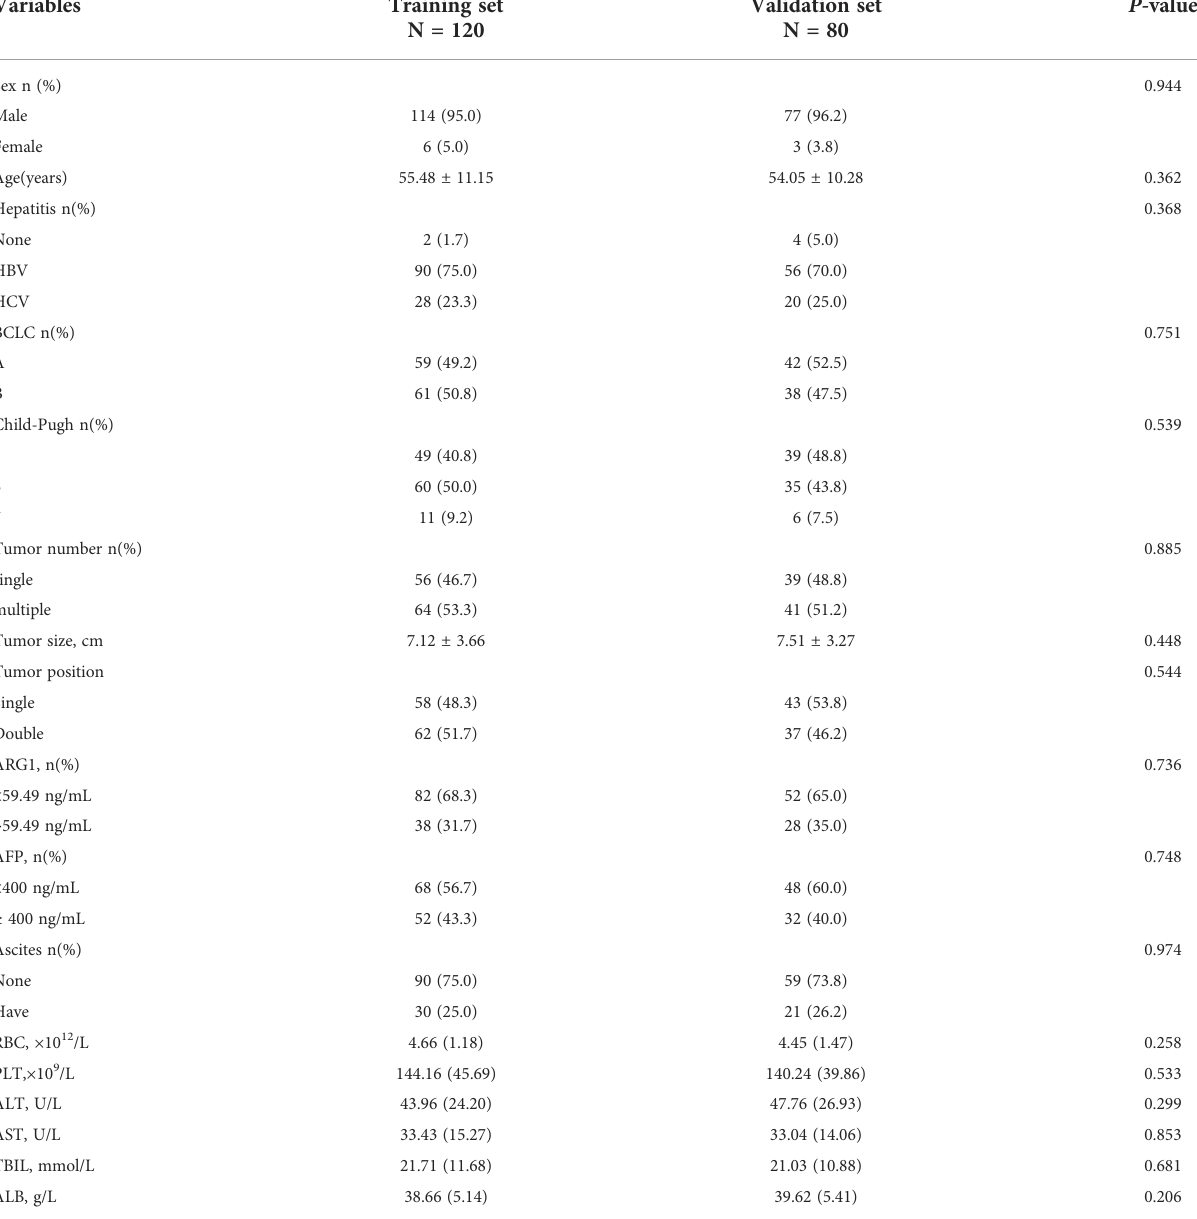
TABLE 1 Baseline characteristics of patients with TACE refractoriness in training set and validation